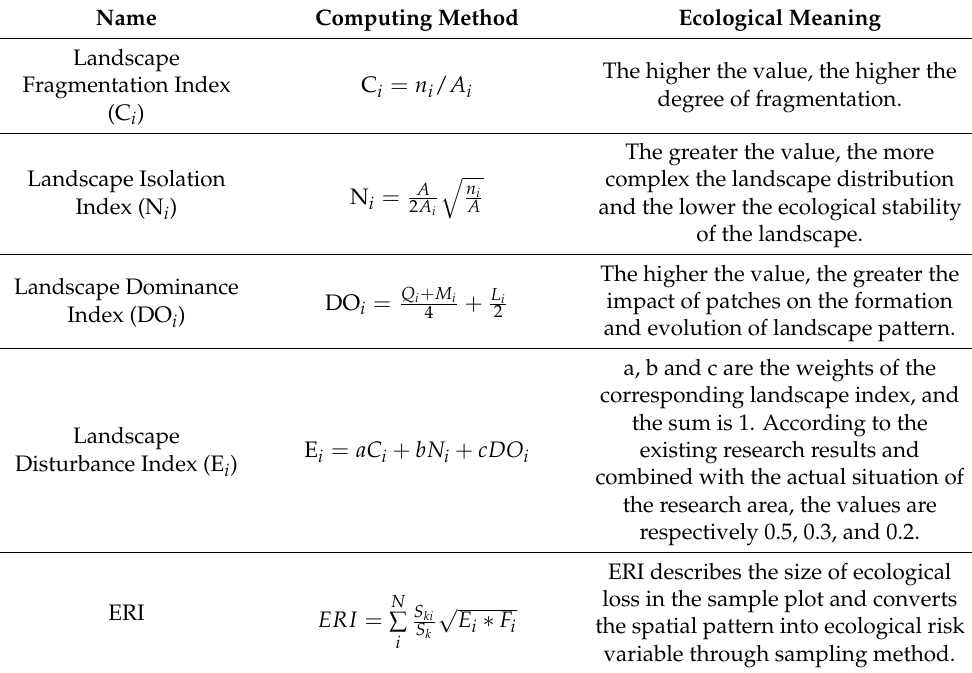
Table 2. Construction method of Landscape